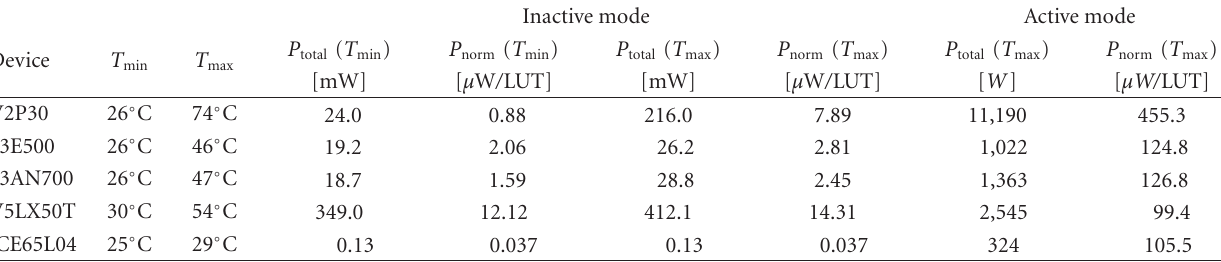
Table 4: Power measurement results. Shown is total and normalised inactive and active